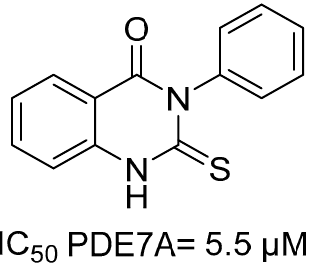
Figure 1. Chemical structure of S14, a selective PDE7 inhibitor.